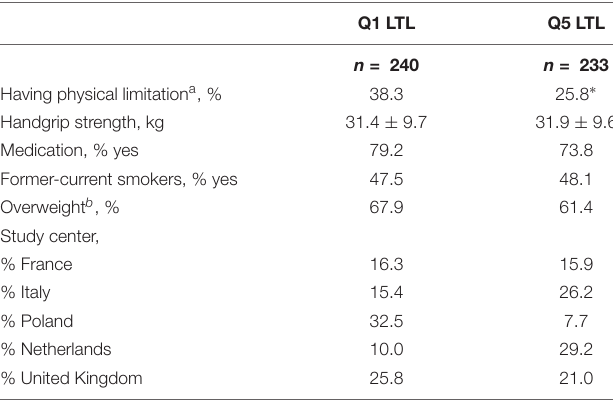
TABLE 2 | Characteristics of the sub-sample population with the shortest (Q1) and the longest (Q5) LTL.